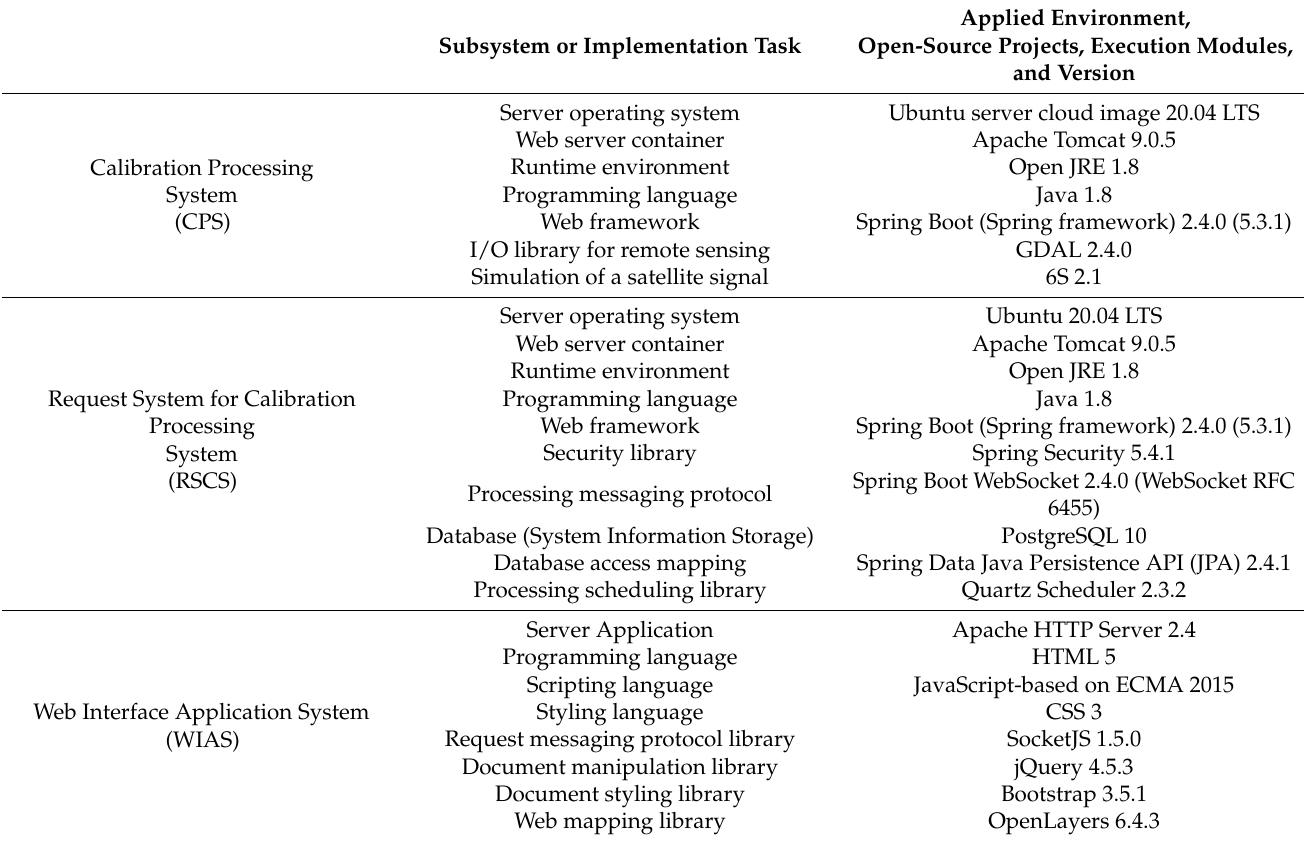
Table 2. List of open source for three subsystems of CPS, RSCS, and WIAS included in